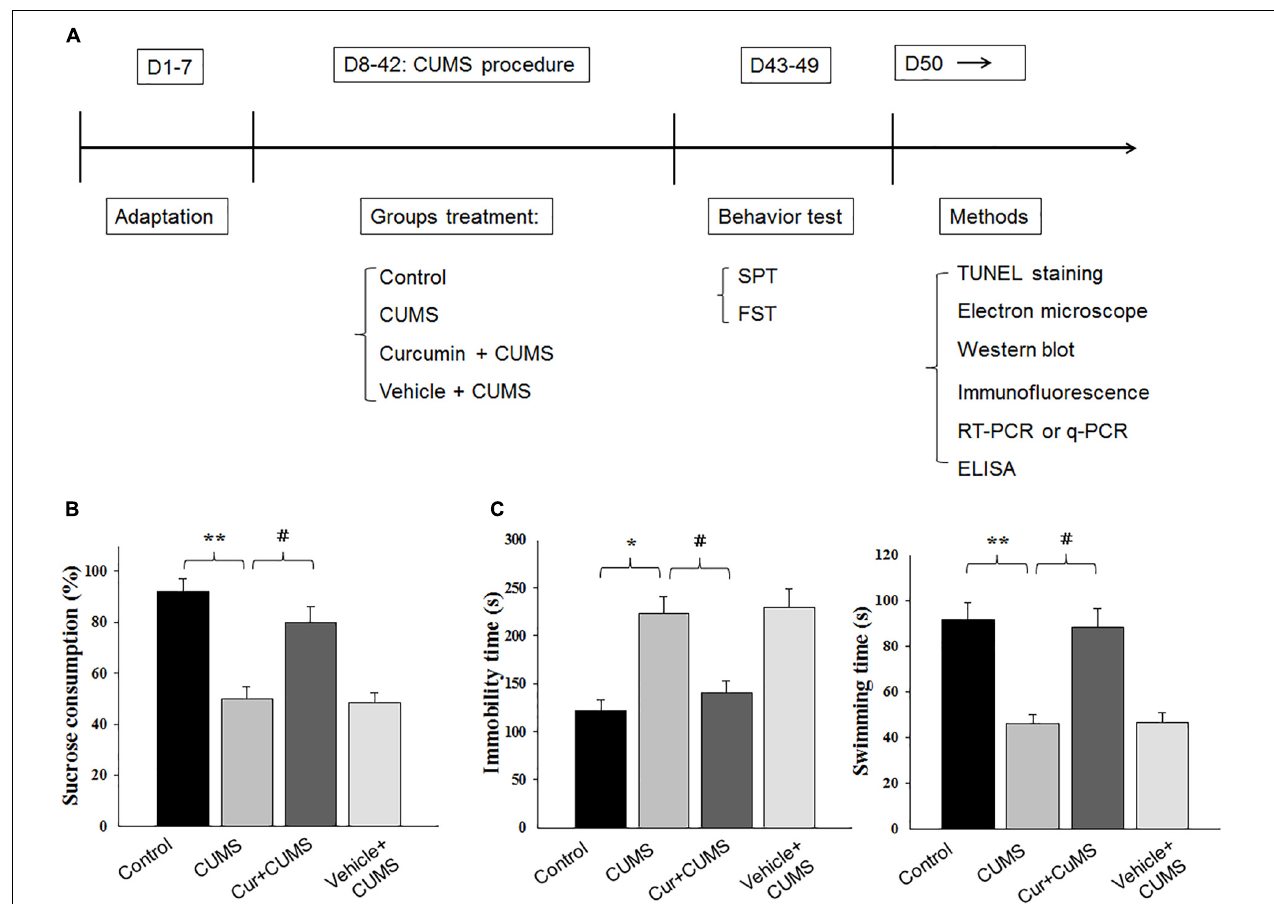
FIGURE 1 | Curcumin rescues CUMS-induced depression-like behaviors in rats. (A) Experimental design: schematic figure of the treatment protocol. (B) Chronic treatment of curcumin (40 mg/kg) reversed the decreases in percent of sucrose consumption of CUMS-exposed rats. (C) Curcumin treatment decreased immobility times and increased swimming times of CUMS-exposed rats in forced swim test. All data are presented as means ± SEM ( N = 18/group). ∗ P < 0.05, ∗∗ P < 0.01, ∗∗∗ P < 0.001 CUMS vs. Control group (non-stressed). # P < 0.05, ## P < 0.01, ### P < 0.001 Cur + CUMS vs. CUMS group (Cur,